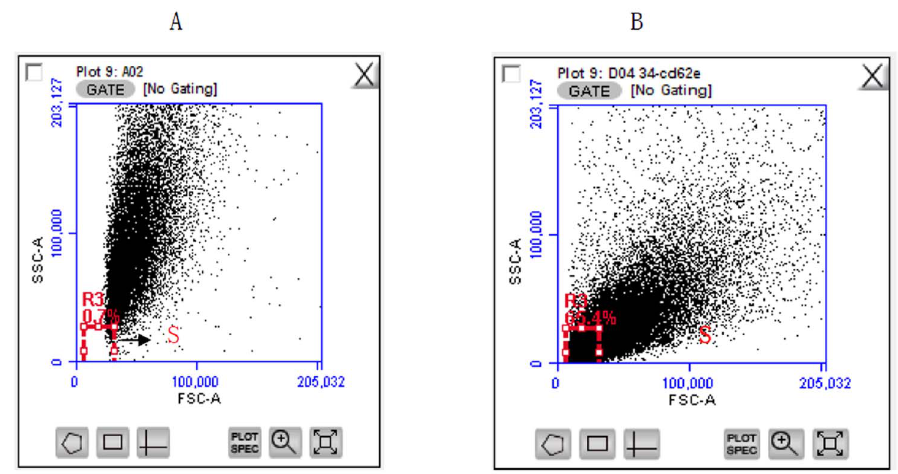
Figure 1. Representive flow cytometric data of circulating SEMPs. (A) Side scatter intensity versus forward scatter intensity dot plot derived from a sample containing standard beads (0.46 m m diameter). (B) Side scatter intensity versus forward scatter intensity dot plot derived from a blood sample containing SEMPs, which were defined as those with a diameter of # 0.46 m m. S window was a gate of MP size.